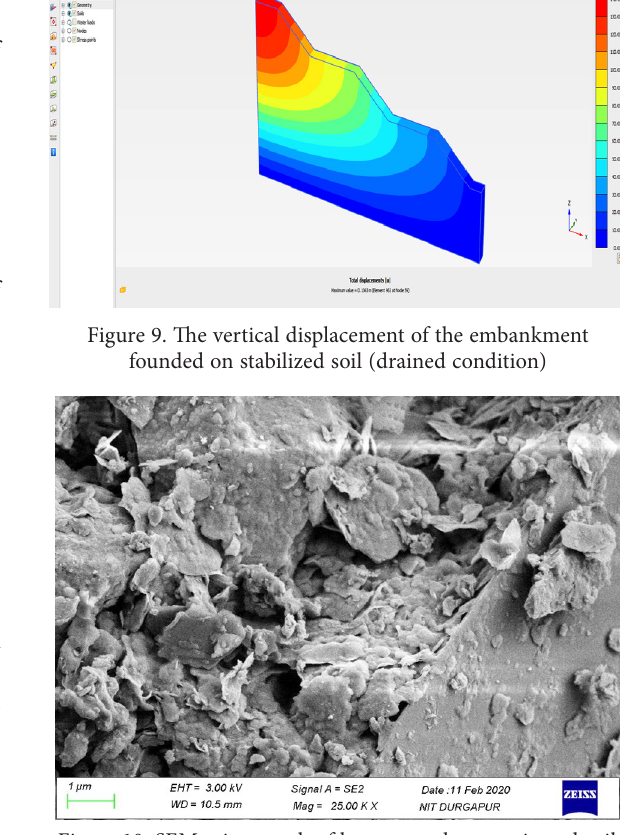
Figure 10. SEM micrograph of heavy metal contaminated